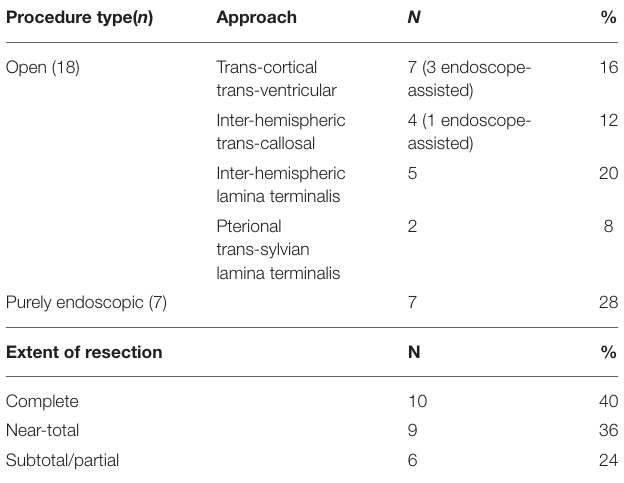
TABLE 4 | Surgical